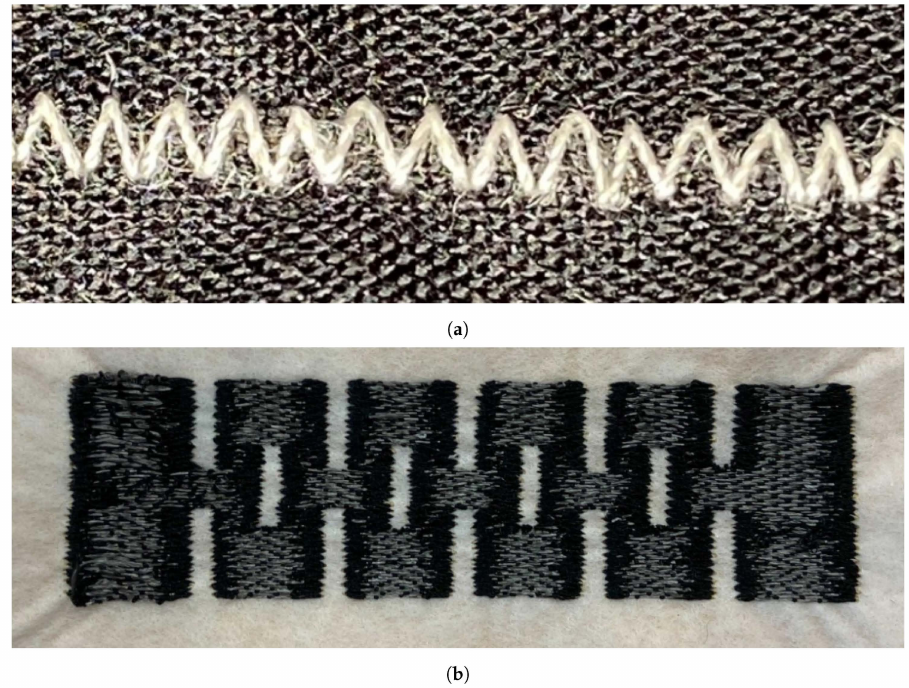
Figure 1. Stitching and embroidery examples. ( a ) A zigzag stitch formed by the interlock of a bobbin and needle thread. ( b ) An embroidery pattern formed by the combination of multiple